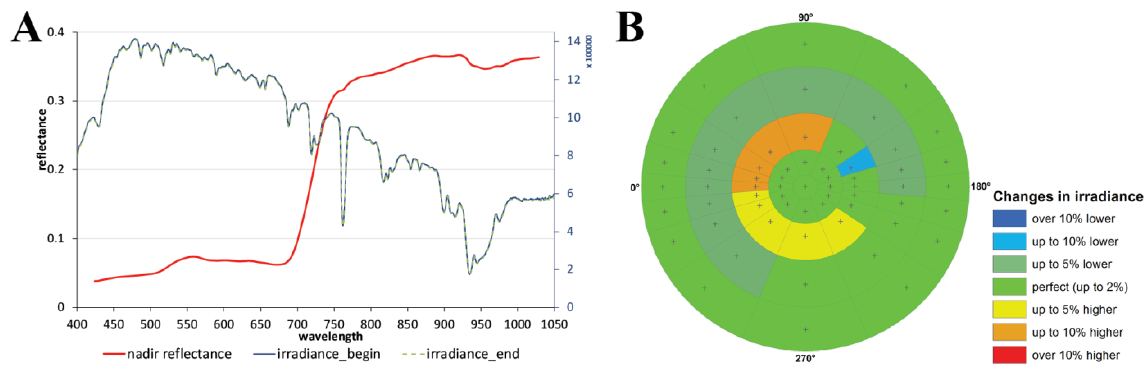
Figure 8. ( A ) Nadir reflectance spectrum and irradiance profiles of the prostrate dwarf shrub-nontussock sedge-moss tundra sample plot FBG2 at the beginning and end of the measurement scheme; ( B ) Polar plot of the outlier indicator showing short-term illumination changes during the measurement